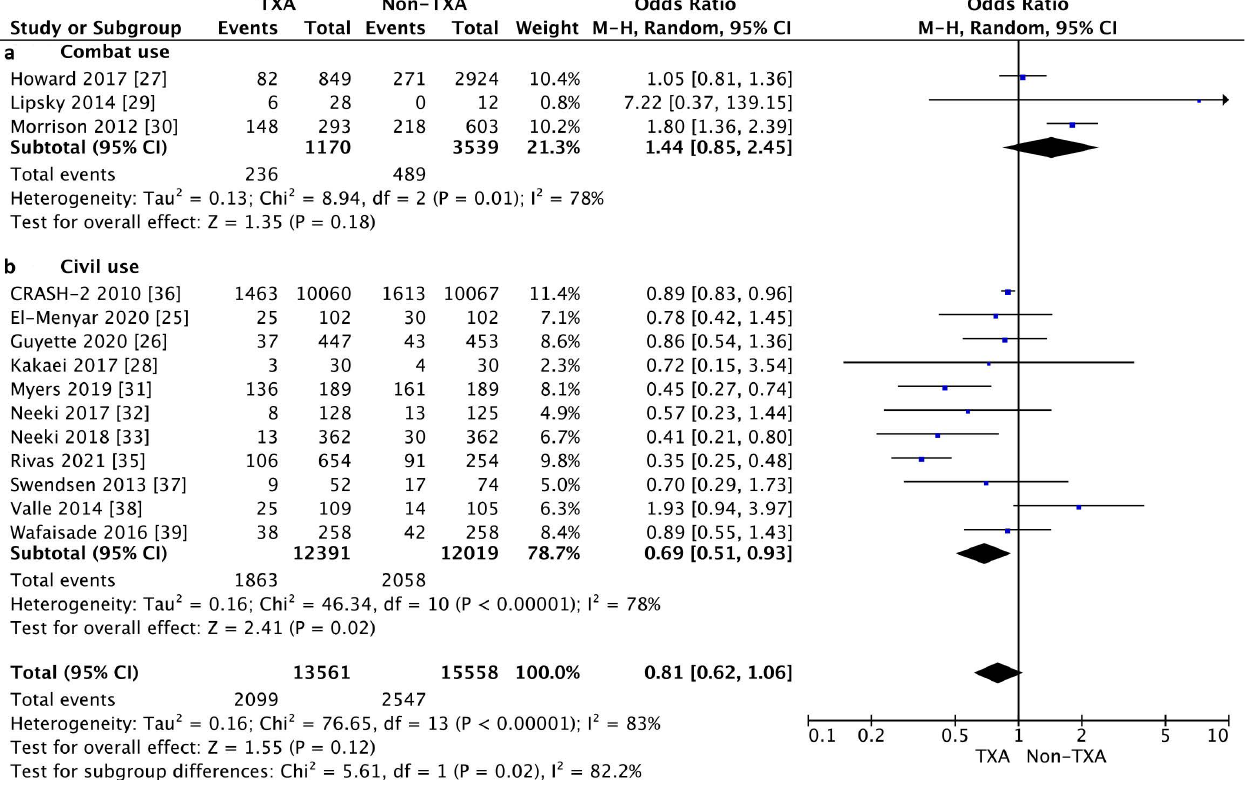
Figure 2. Forest plot of in-hospital mortality in the TXA group vs. non-TXA group. ( a ) Combat injuries; ( b ) Civilian injuries. The center of each square represents the weighted odds ratio (OR) for individual trials, and the corresponding horizontal line stands for the 95% confidence interval (CI). The diamonds represent pooled